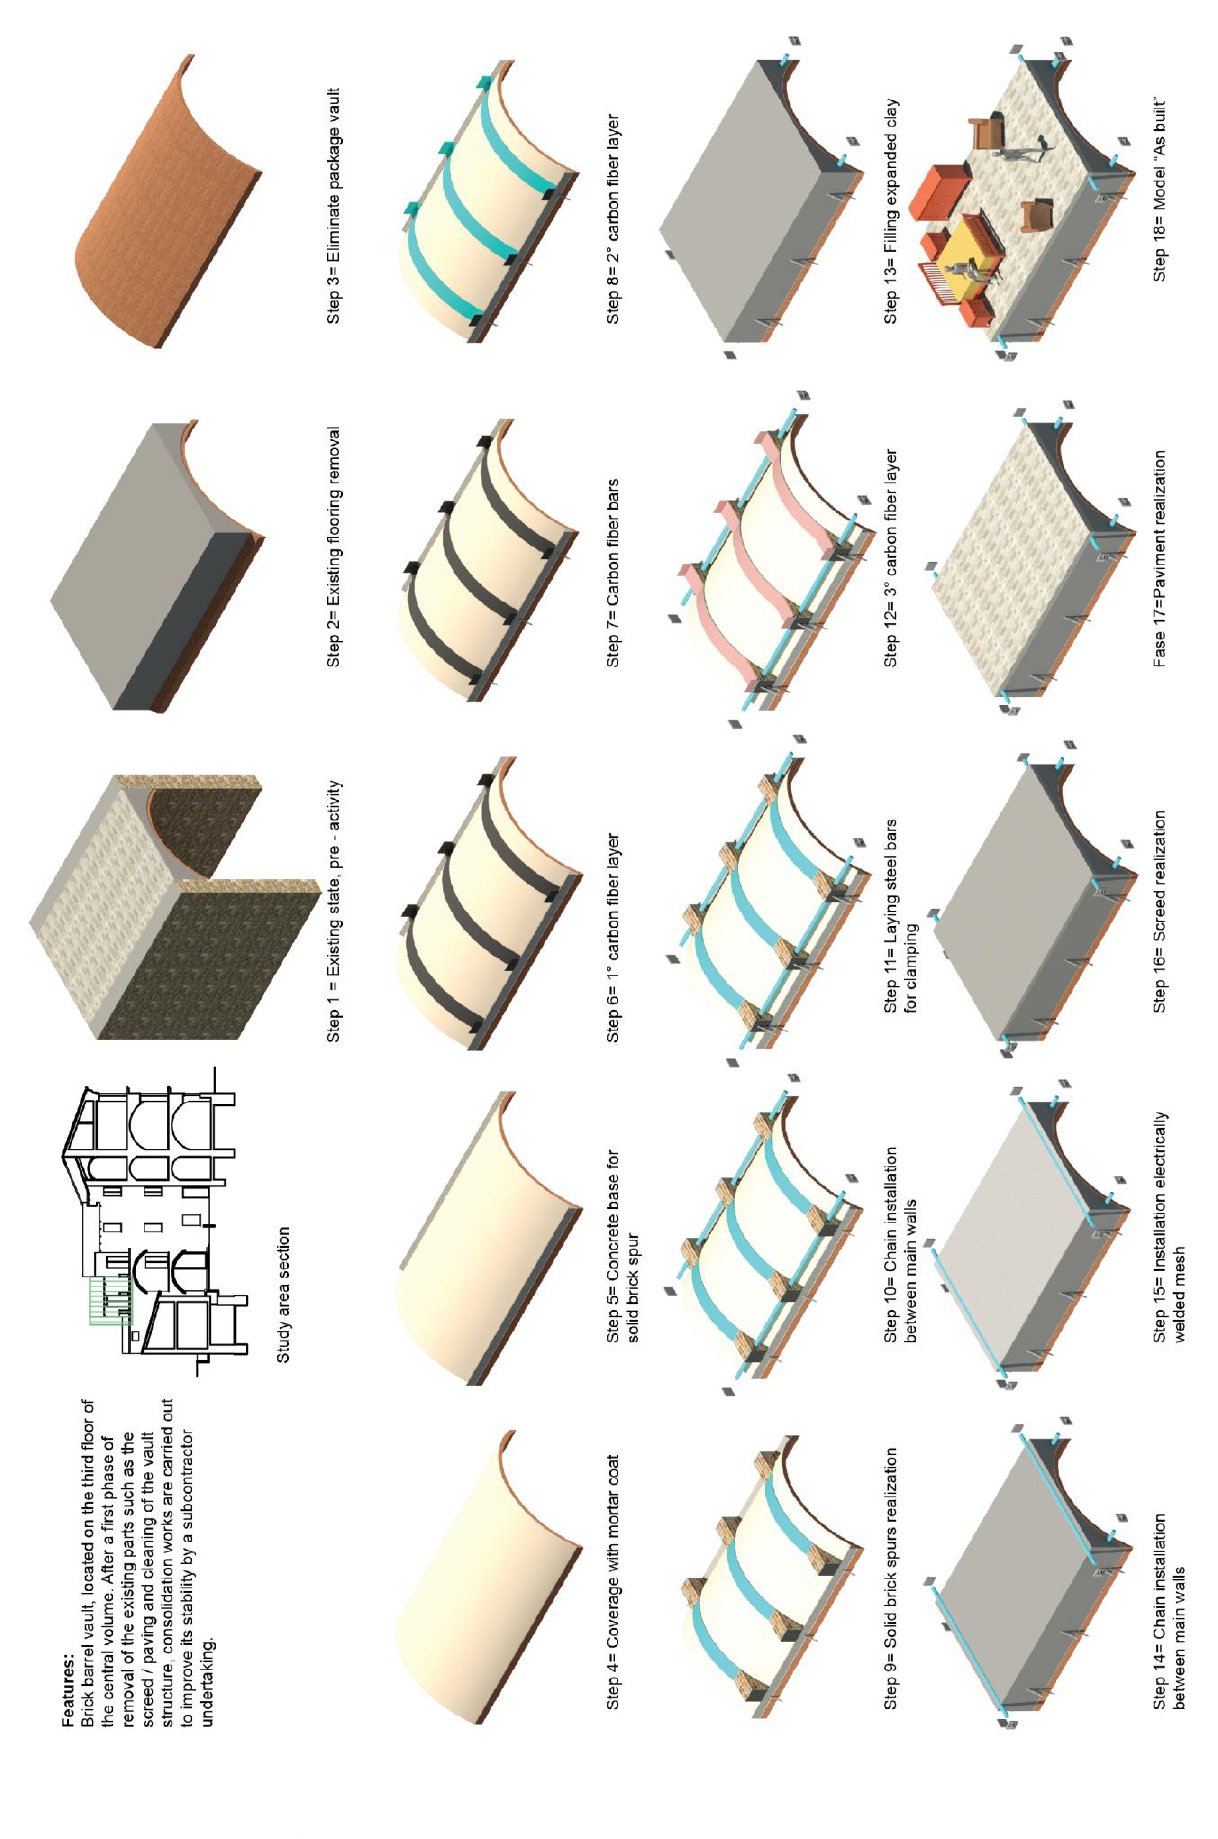
Figure 6: Evolutionary phases of vault consolidation and tie rods insertion modeled in